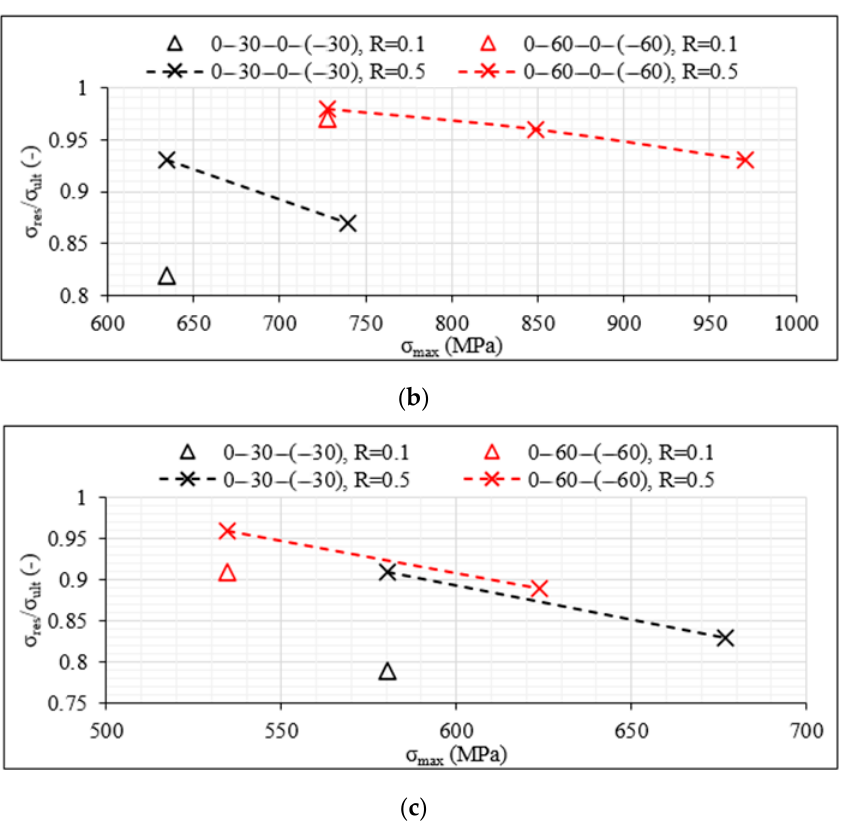
◦ / θ ] ◦ / θ /0 ◦ / − θ ] s and 2s , ( b ) [0